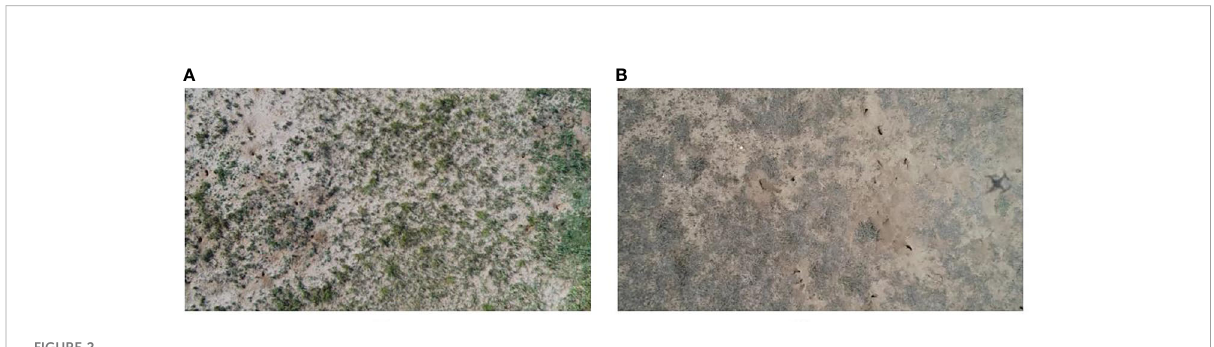
FIGURE 2 UAS photos captured in summer (A) and winter (B)